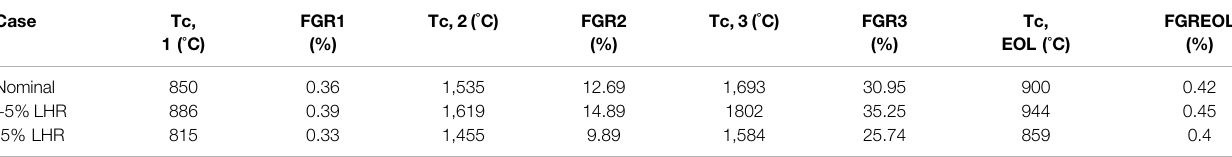
TABLE 1 | Main results from the simulation of the simpli fi ed FUMEX case (van Uffelen et al., 2002).